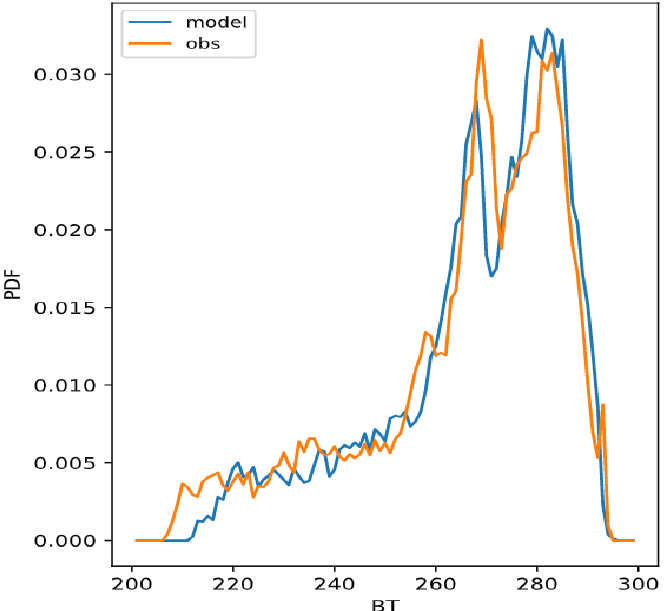
Figure 4. Probability density function (PDF) of the observed and model forecast IR BT. The cloud top IR BT represents radiation emitted by cloud tops into space; a lower BT indicates a higher cloud top, which indirectly indicates the strength of the convective activity and thus the intensity of TC. Therefore, the HAFS model’s prediction of less cold GOES-R IR BT—a model warm bias—suggests the model underpredicts the cloud top, and thus the TC intensity. This evaluation result is confirmed by the traditional TC intensity metrics in Figure 5, which shows that the model forecasted higher TC minimum sea level pressure and lower maximum wind speed than the best tracks. As a result, the evaluation from the GOES IR BT images are consistent with the traditional TC intensity